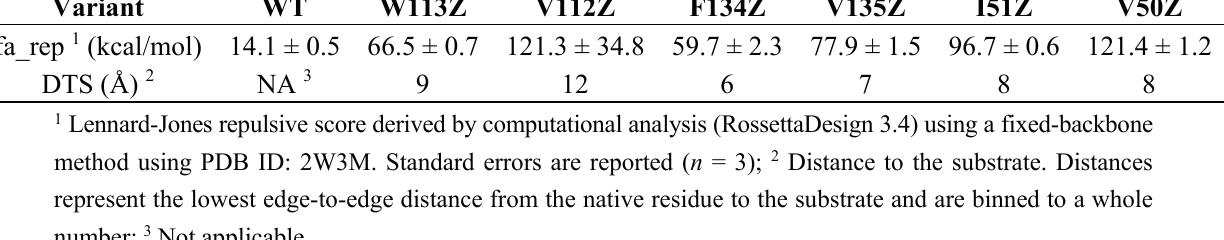
Table 1. Parameters derived from computational and crystal structure analysis.